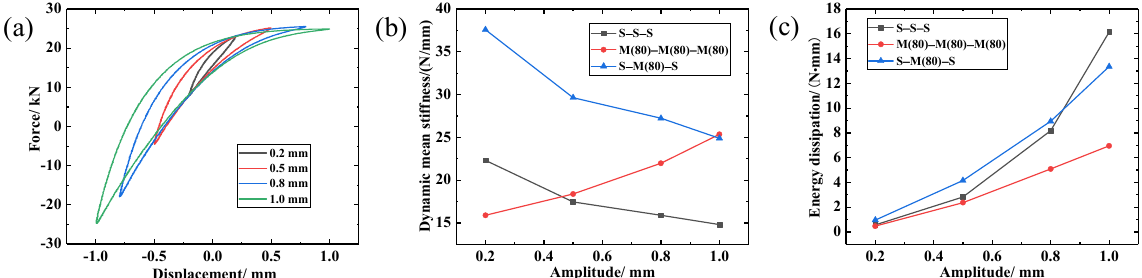
Figure 15. Dynamic performance of LCDS under different amplitudes: ( a ) Hysteresis loops under different amplitudes; ( b ) Variation of dynamic mean stiffness under different amplitudes; ( c ) Variation of energy dissipation under different amplitudes.